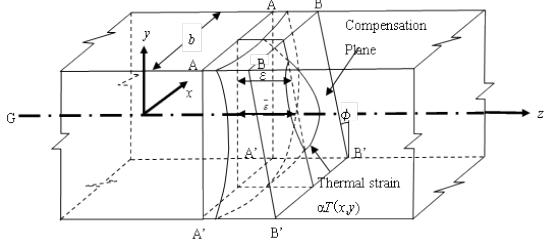
Figure 2. Concept of